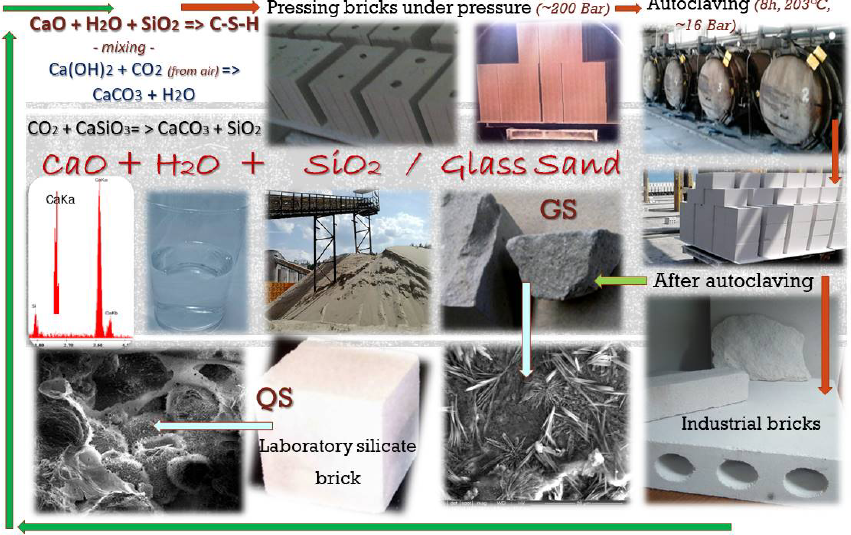
Figure 5. Production process of sand ‐ lime brick in industrial conditions